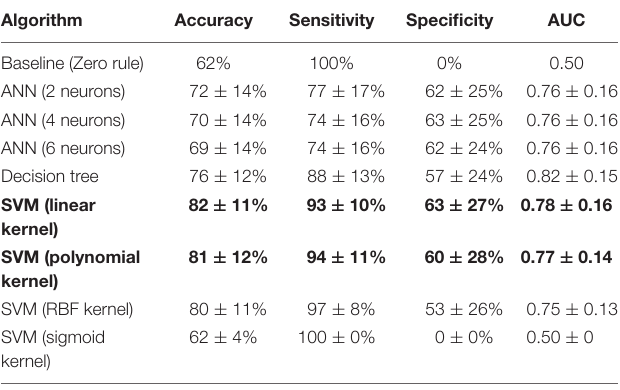
The abbreviation RBF stands for radial basis function kernel. The two models in bold are the best performing models. TABLE 5 | Confusion matrix for the performance of the SVM (linear) for the controls-patients comparison.